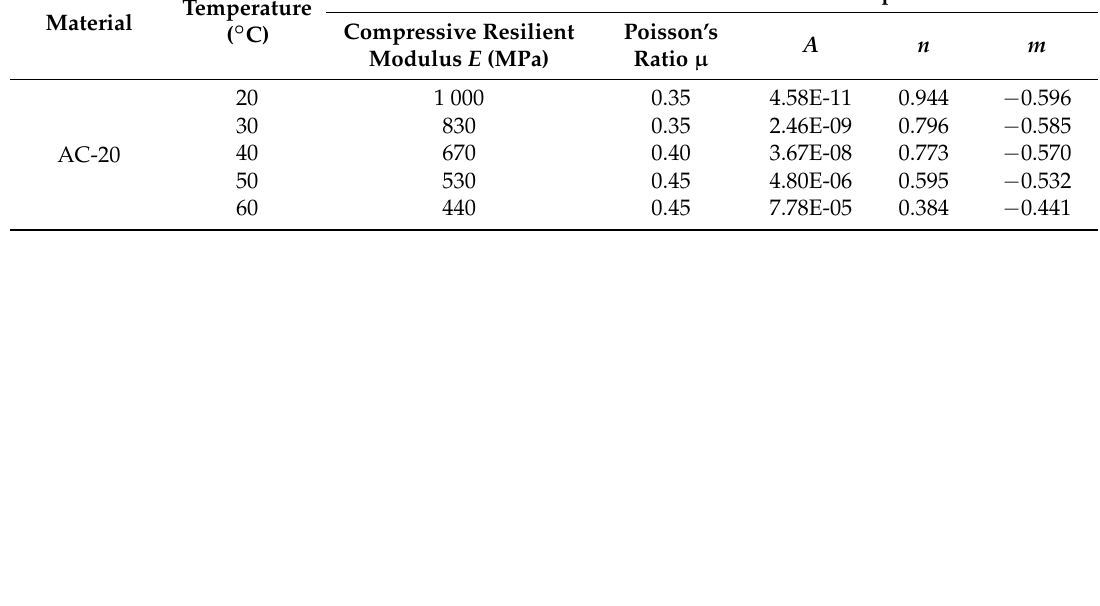
Figure 11. Distribution of creep strain at different depths under the left dual-wheel center.